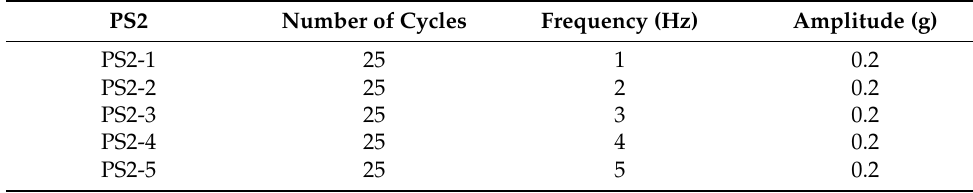
Table 5. Details of parametric study PS2.